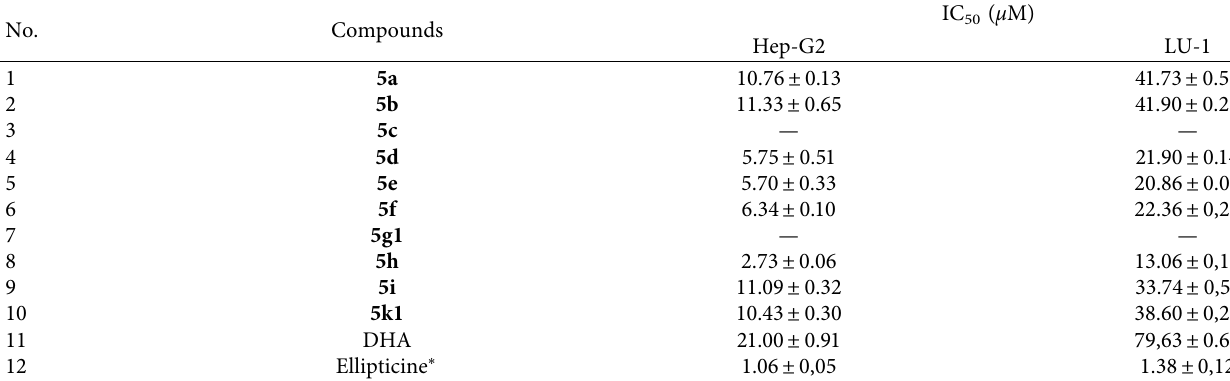
Table 3: In vitro cytotoxic activity of the synthesized